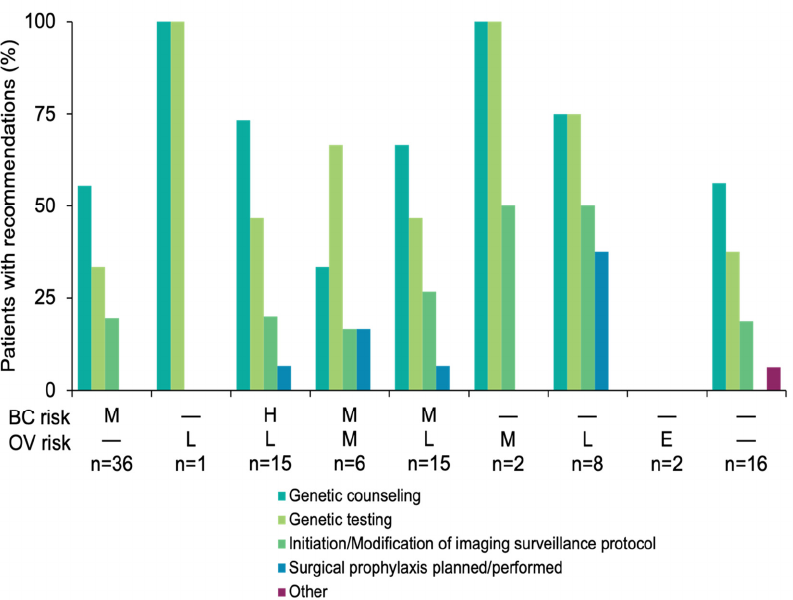
Figure 3. Clinical recommendations made to family members. The percent of family members who received each recommendation was reported. The number of patients for whom family members were reported to receive recommendations (numerator) versus the number of patients with a P/LP variant in each gene risk group (denominator) is reported in the x -axis. Recommendations were made to family members of patients with variants in the following genes: moderate breast cancer risk only ( CDH1 , CHEK2 , PTEN , TP53 ); minimally increased breast cancer risk only ( FANCC ); moderate breast cancer and minimally increased ovarian cancer risk ( PALB2 ); moderate breast and ovarian cancer risks ( NF1 , RAD51C ); moderate breast cancer risk and minimally increased ovarian cancer risk ( ATM, NF1|BRIP1 ); moderate ovarian cancer risk only ( MSH2 ); minimally increased ovarian cancer risk only ( BRIP1 , MSH6 , PMS2 ); other cancer risks ( APC , FH , MITF , MUTYH , SDHB ). Other recommendations include: carrier screening. Other family member implementation response: colonoscopy and family in process of receiving genetic testing. BC, breast cancer; E, elevated but undefined risk due to limited data; H, high; L, minimally increased; M, moderate; OV, ovarian cancer; P/LP, pathogenic/likely